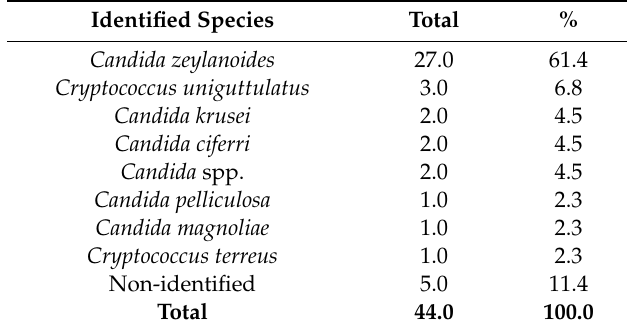
Table 4. Identified molds and yeasts from cultures in PCA, in number of isolates and respective percentage from the total of lactic acid bacteria.